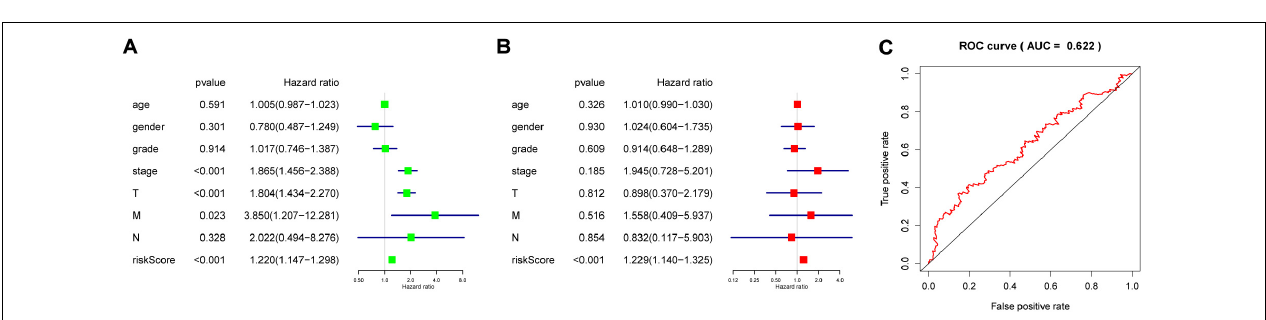
FIGURE 8 | The role of risk score in prognosis. Single (A) and multiple (B) factors used in the Cox analysis to develop the risk scores in LIHC. (C) ROC curve showing the supporting the performance of the model. LIHC, liver hepatocellular carcinoma; ROC, receiver operating